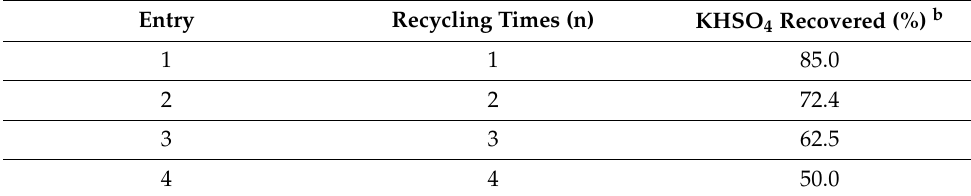
Table 6. Reusability of KHSO 4 a